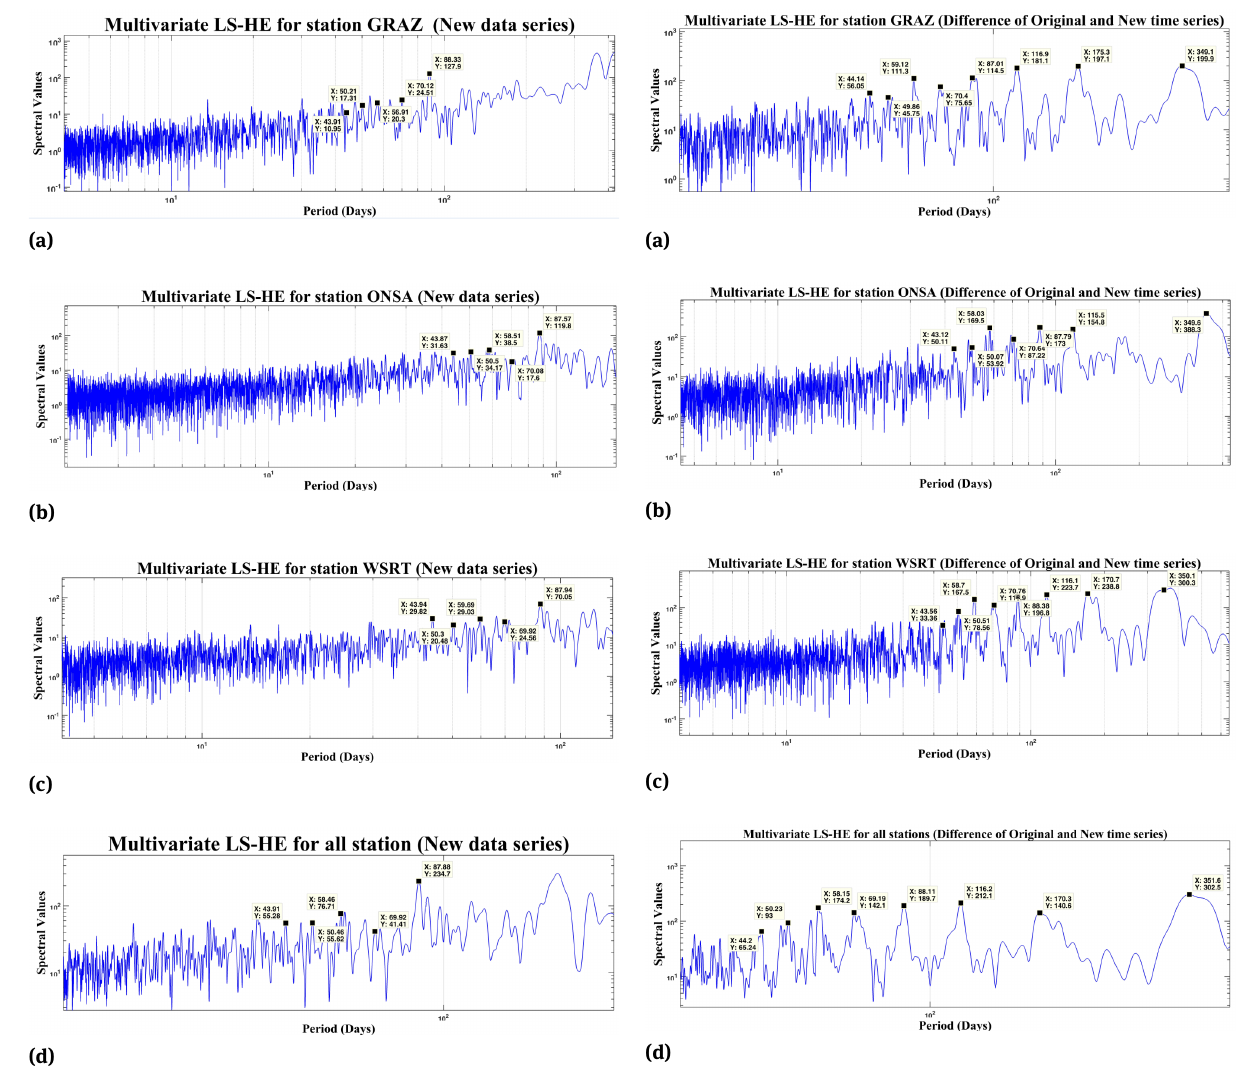
Figure 12: loglog plot for multivariate LSHA of difference between original and new time series - X is period and Y is spectral